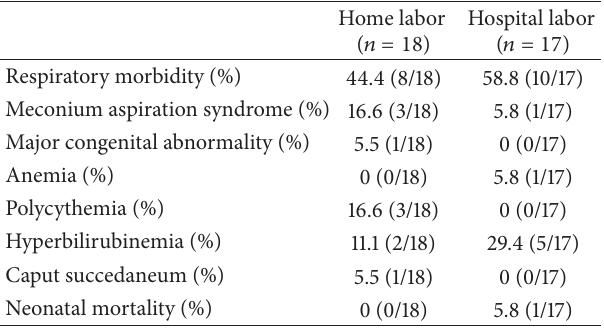
Table 3: Details of outcomes of the infants admitted to the neonatal intensive care unit in the study and control groups.